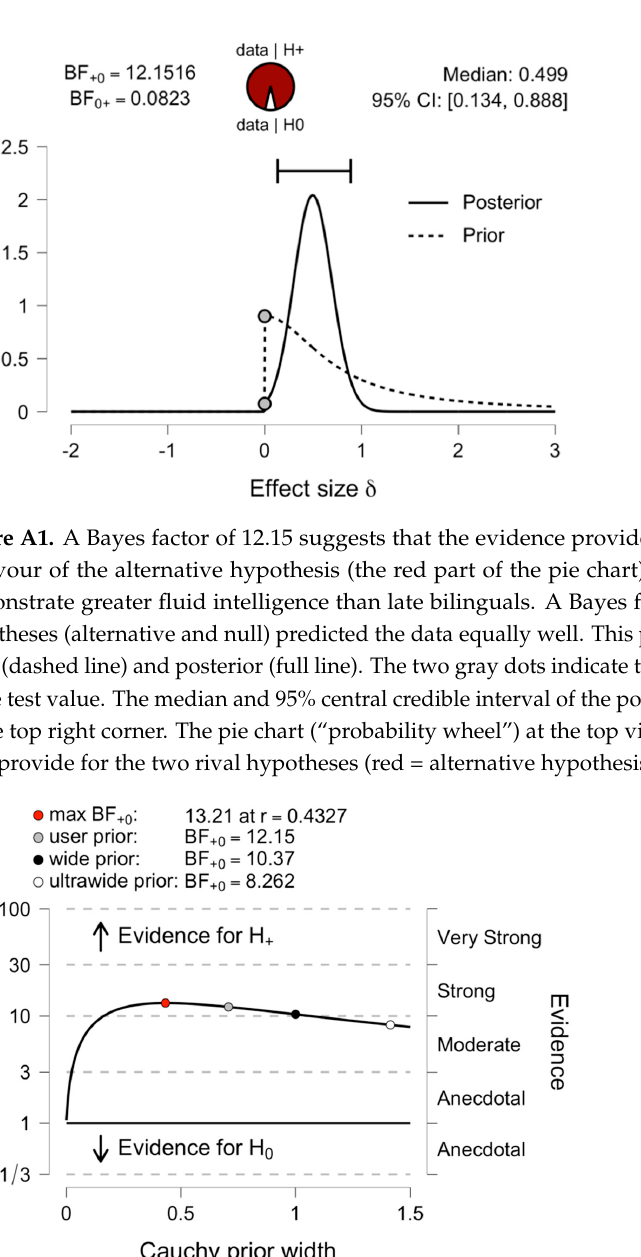
Figure A2. The Bayes factor robustness check. The maximum Bayes factor (BF +0 ) is attained when setting the prior width r to 0.43. The plot indicates BF +0 for the user specified prior ( r = 1/ √2 ), wide prior (r = 1), and ultrawide prior ( r = √2 ). The evidence for the alternative hypothesis is somewhat stable across a wide range of prior distributions, suggesting that the analysis is robust.